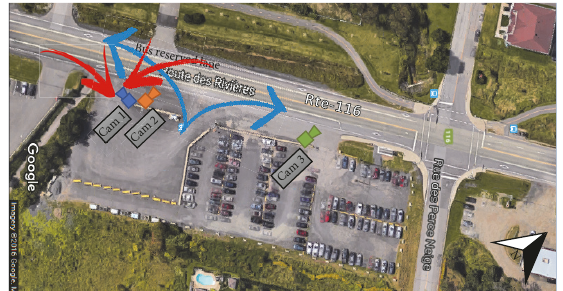
Figure 5: Paths of the terminal-bound